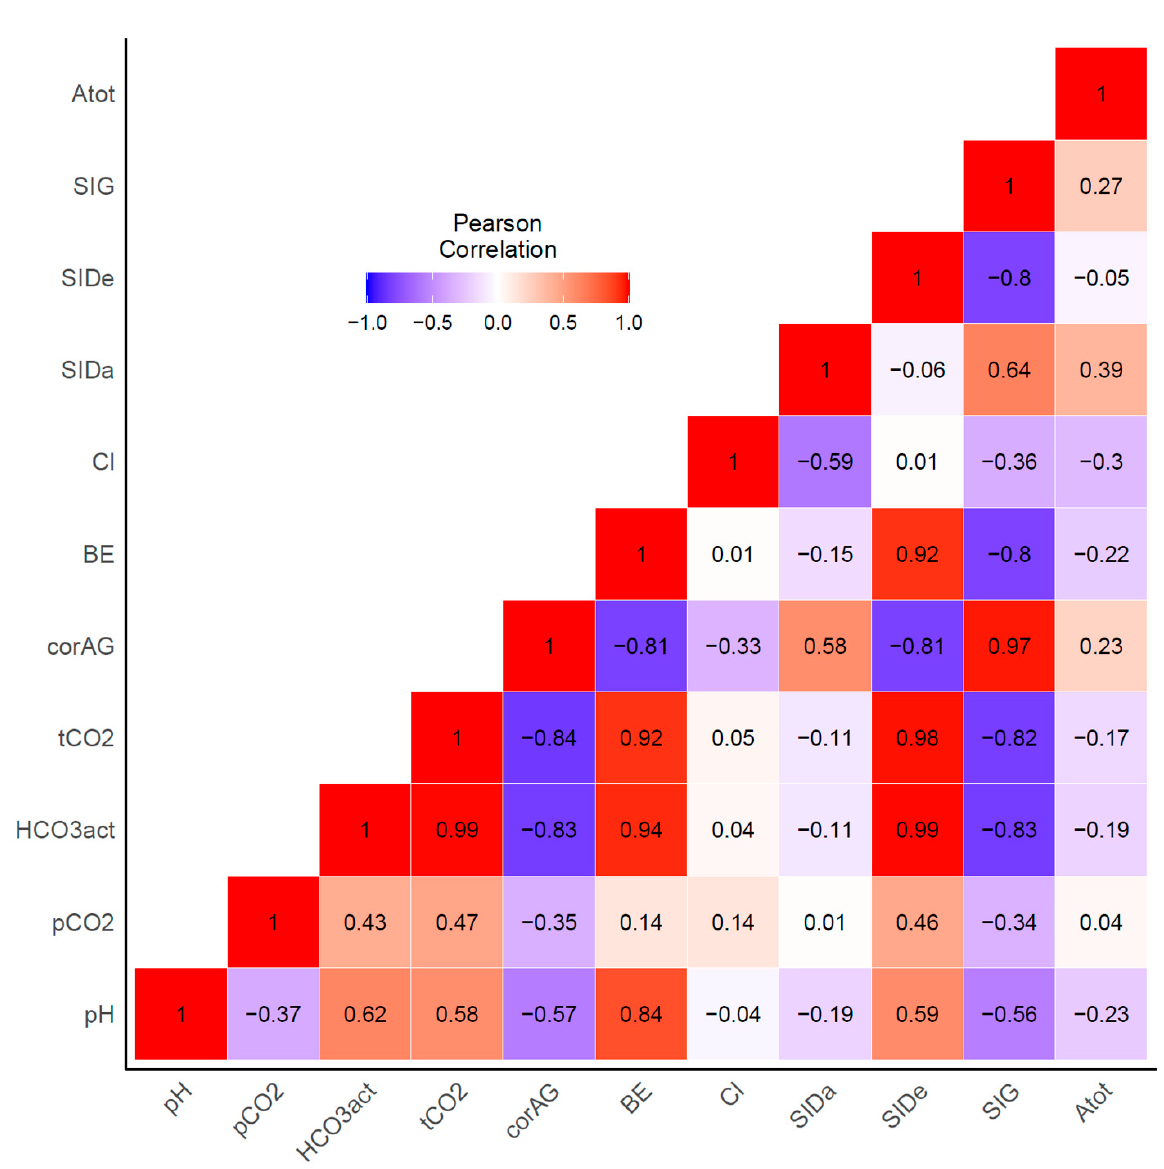
inversed to negatively association in the multivariable analysis or vice versa, as observed in Table 3, e.g., odds ratios of SIDa in the univariable was 1.16; however, changed to 0.86 in the multivariable analysis), indicating that the traditional statistical models were inappropriate for our data. To address these intercorrelations between variables, we performed PCA. Toxics 2021 , 9 , x FOR PEER REVIEW